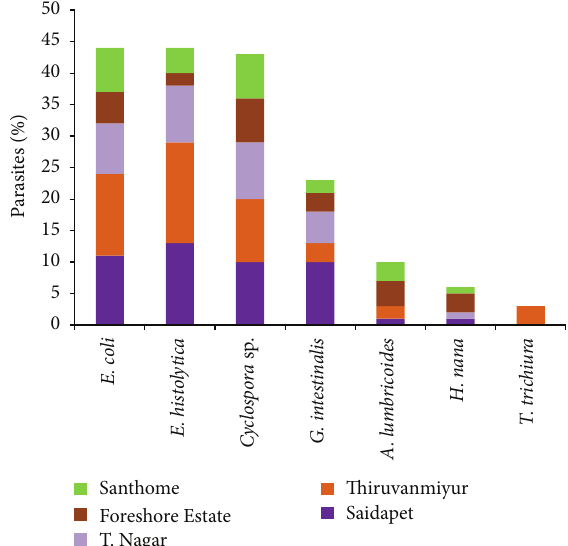
Figure 5: Distribution of parasites among different areas from south